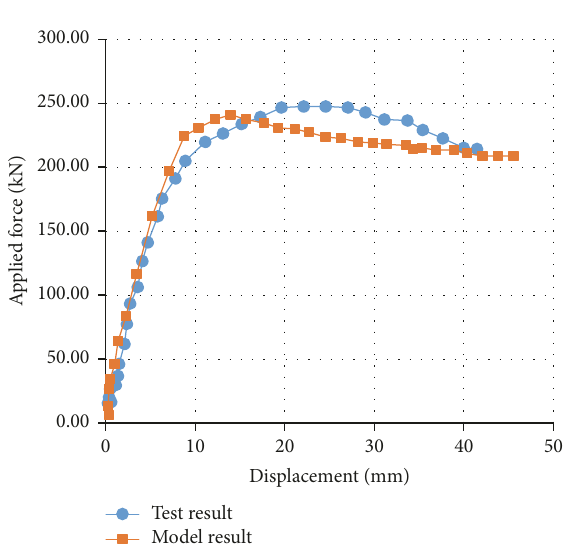
Figure 5: Load-displacement curve of SRC hybrid frame.